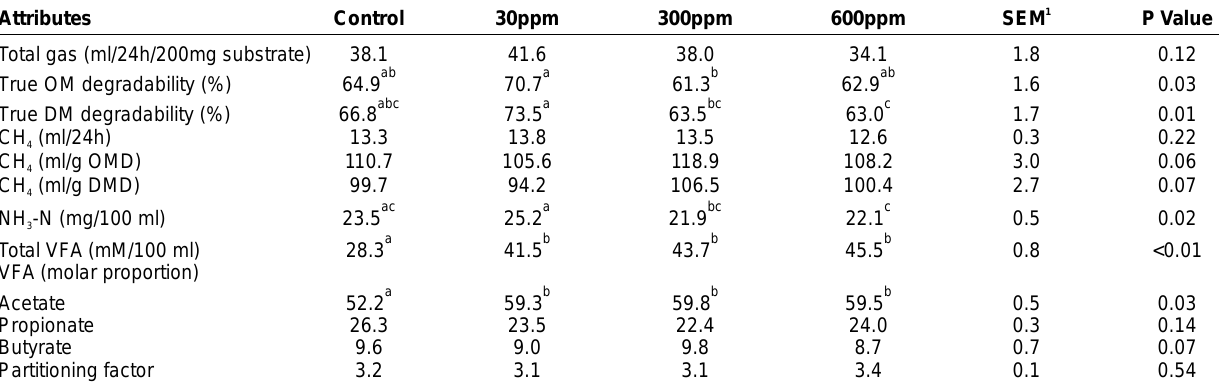
Table-2: Effect of different levels of cinnamon oil on in vitro fermentation in wheat straw based (Concentrate: Roughage= 50:50) diet